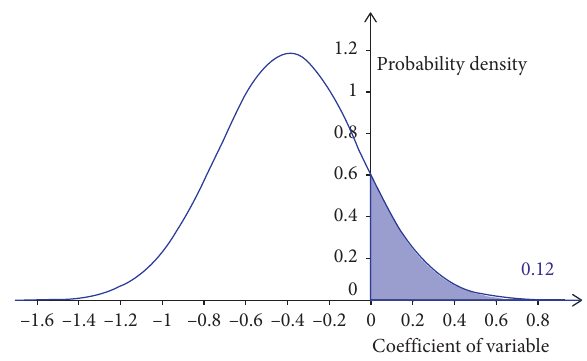
Figure 5: Varying effects of access time on passengers’ express bus